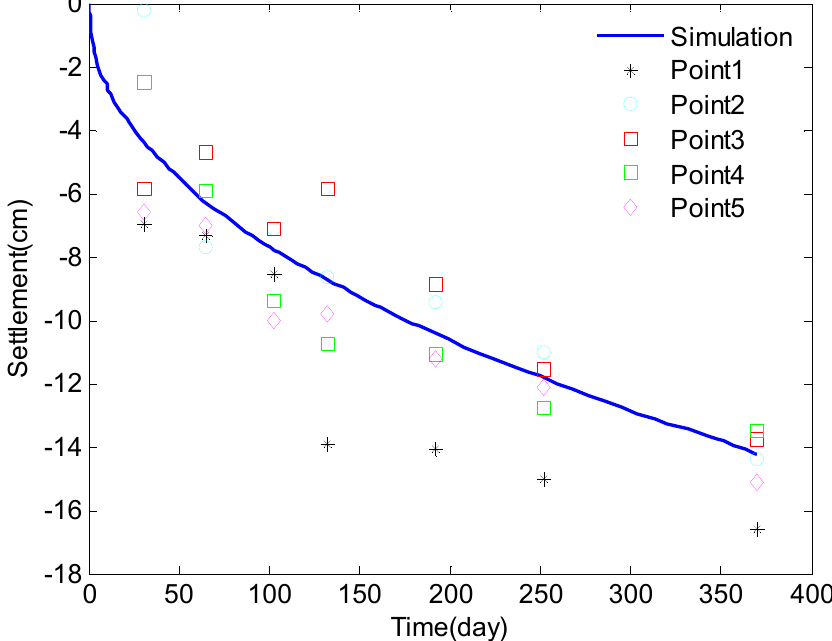
Figure 8. Validation of the long-term settlement model by using the simulation result and measured data (source data: [42]).